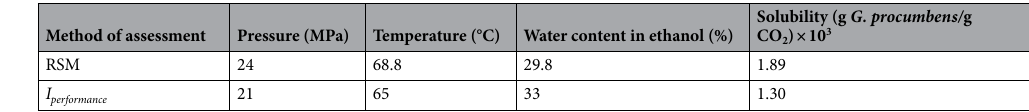
Table 11. Comparison of the solubility data obtained from different methods of performance.